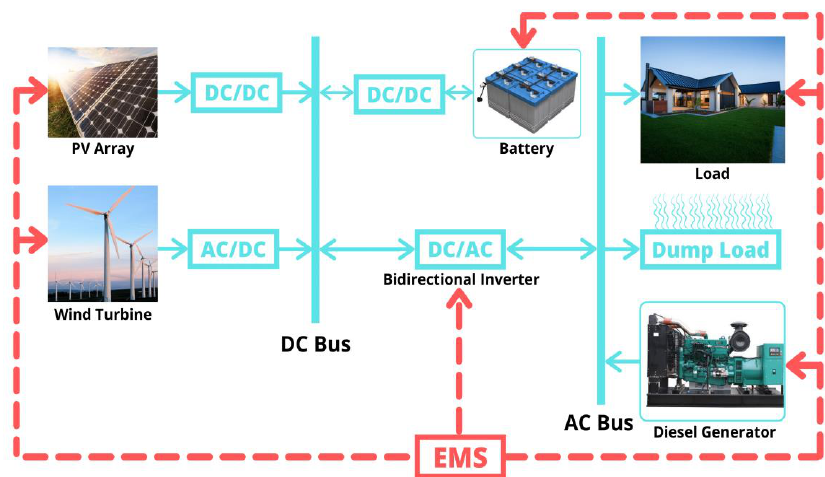
Figure 1. Stand-alone microgrid system configuration.